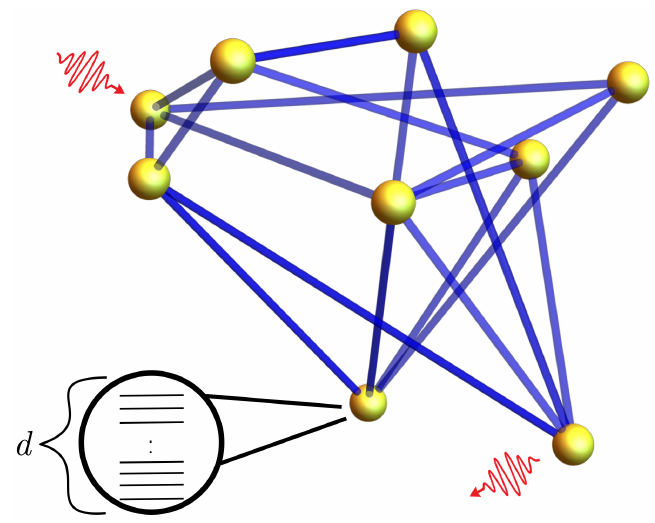
Figure 1: An arbitrary interacting quantum many-body system of N sites (illustrated as yellow spheres) which may interact with each other along the blue bonds. The sites also interact with the background environment, illustrated by the red arrows. The sites each have a finite local Hilbert space, illustrated as dimension d on one of the sites (i.e. each site has exactly d levels). This is the general system of interest we will be focusing on. The goal will be to synchronize observables between different sites in the system. Crucially, the sites that are to be synchronized do not have ¯ h → 0 or equivalent large parameter (semi-classical) limits. Rather we make no assumptions on the size of the local Hilbert